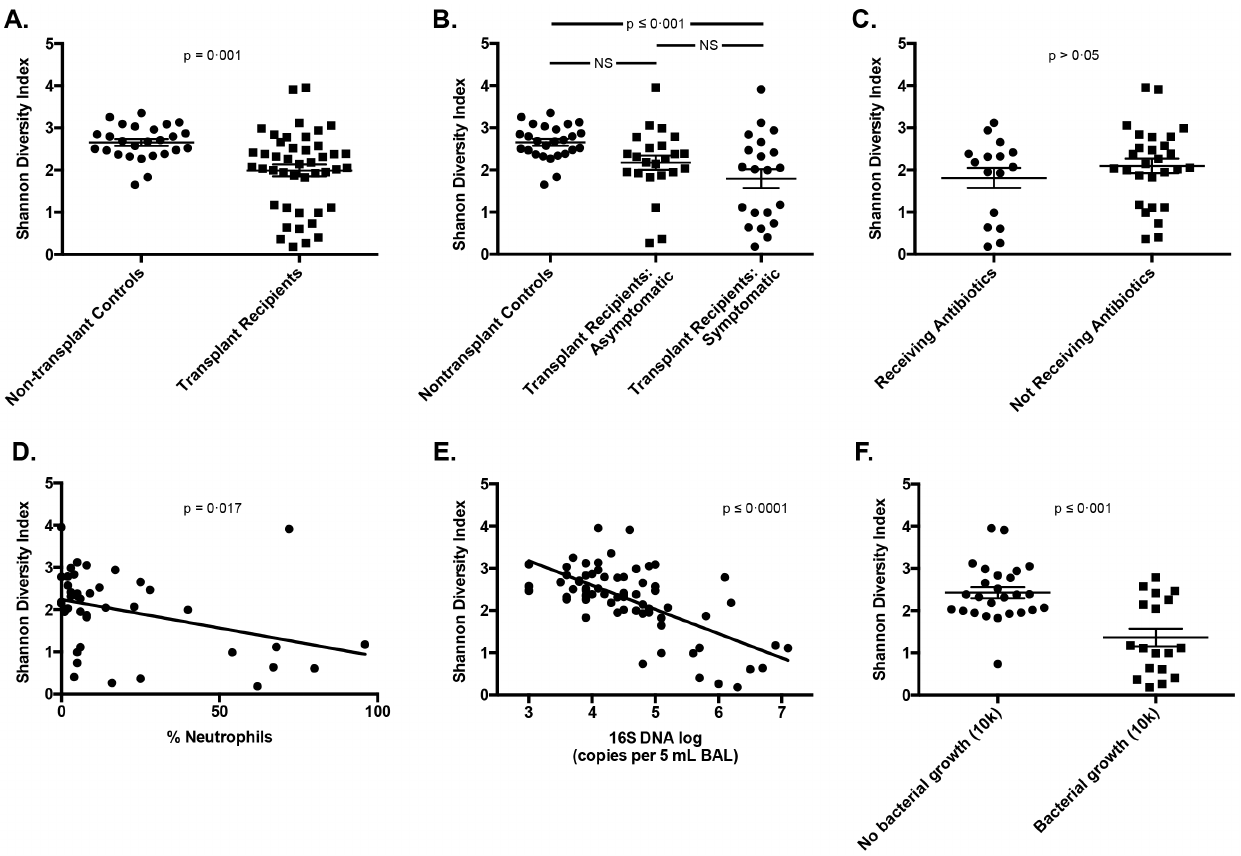
Figure 4. Shannon Diversity Indices of bacterial communities in BAL samples from lung transplant recipients. A-C: Comparison of bacterial community diversity by transplant status (A), specimen group (symptomatic/transplant status) (B) and antibiotic exposure (C). D-E: Bacterial community diversity correlated with BAL neutrophilia (D) and 16S DNA (E). F: Comparison of bacterial community diversity among transplant subjects by culture results. Comparison of group means performed with unpaired t-test and ANOVA with Tukey’s multiple comparisons test. Continuous variables assessed for correlation with linear regression.